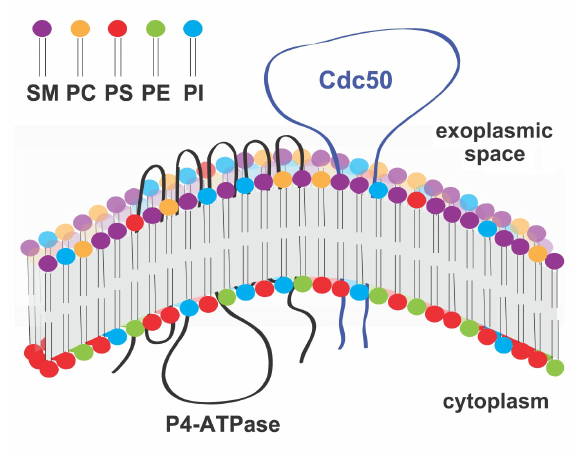
FIGURE 1: Predicted topological model of P4-ATPase and its reg- ulatory subunit Cdc50. Cdc50 interacts with P4-ATPase through its exocytoplasmic loop to activate the lipid flippase function, which translocates specific phospholipids from the exocytoplas- mic leaflet to the cytoplasmic leaflet of the lipid bilayer mem- brane. SM: sphingomyelin, PC: phosphatidylcholine, PS: phospha- tidylserine, PE: phosphatidylenthanolamine, PI: phosphatidylinosi- tol.